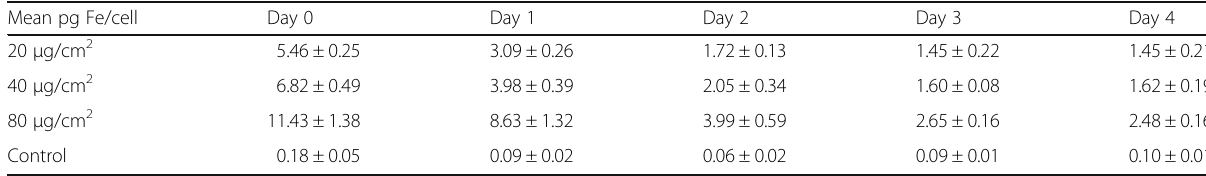
Table 1 Short-term cellular iron quantification Mean pg Fe/cell